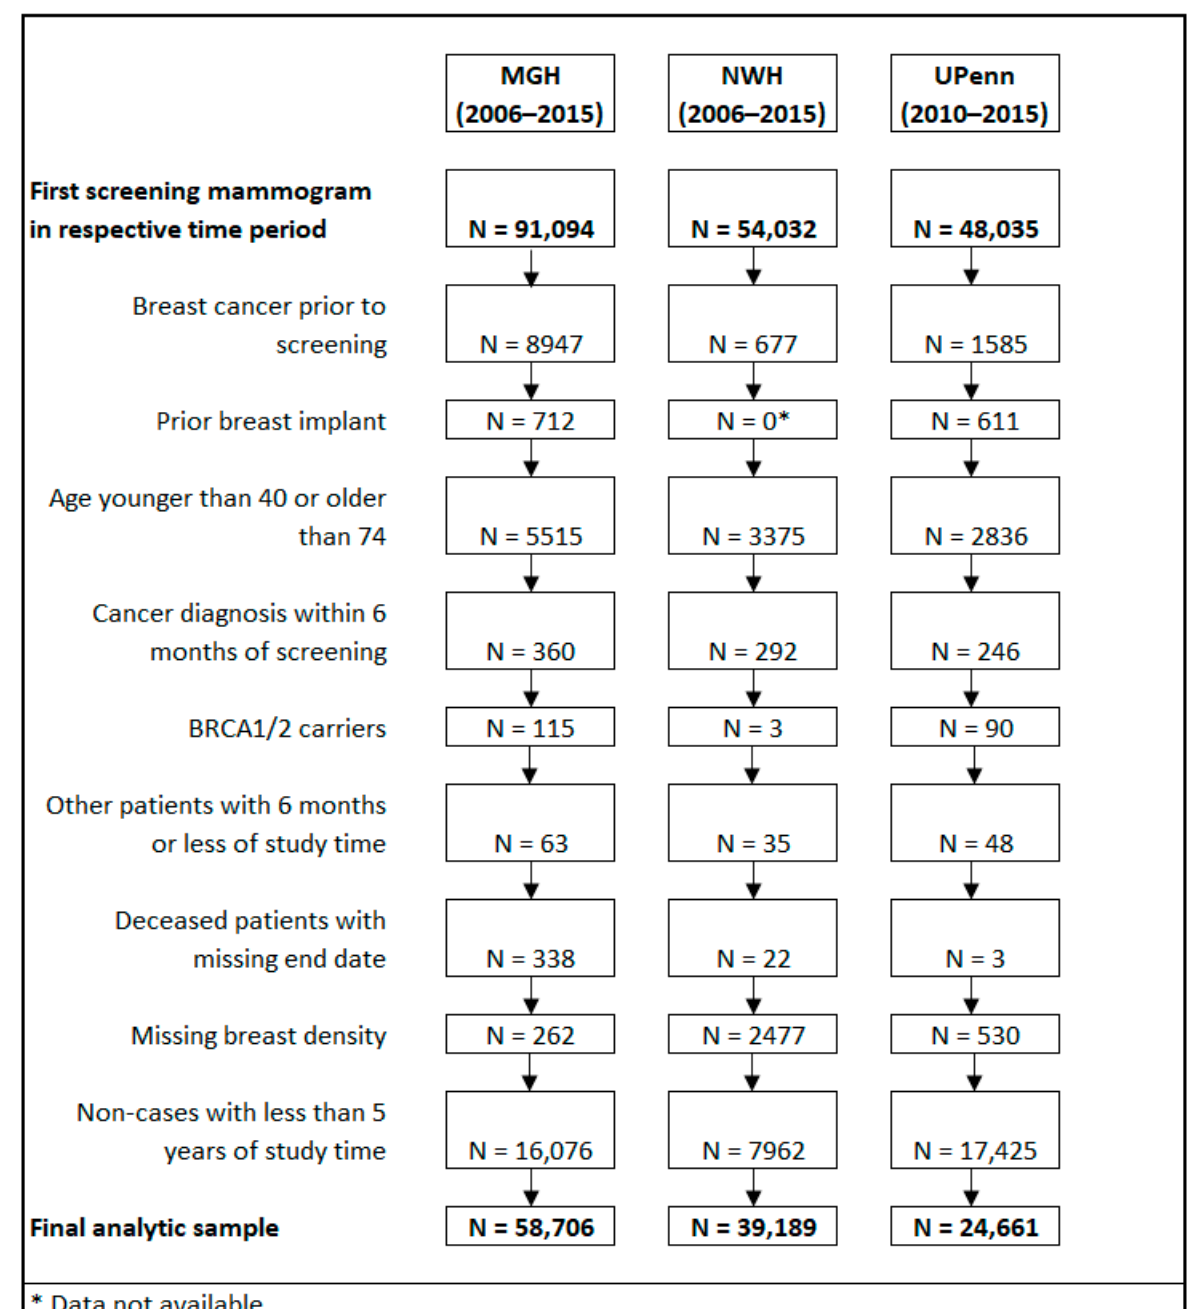
Figure 1. Exclusion criteria for screening mammography population by study site.